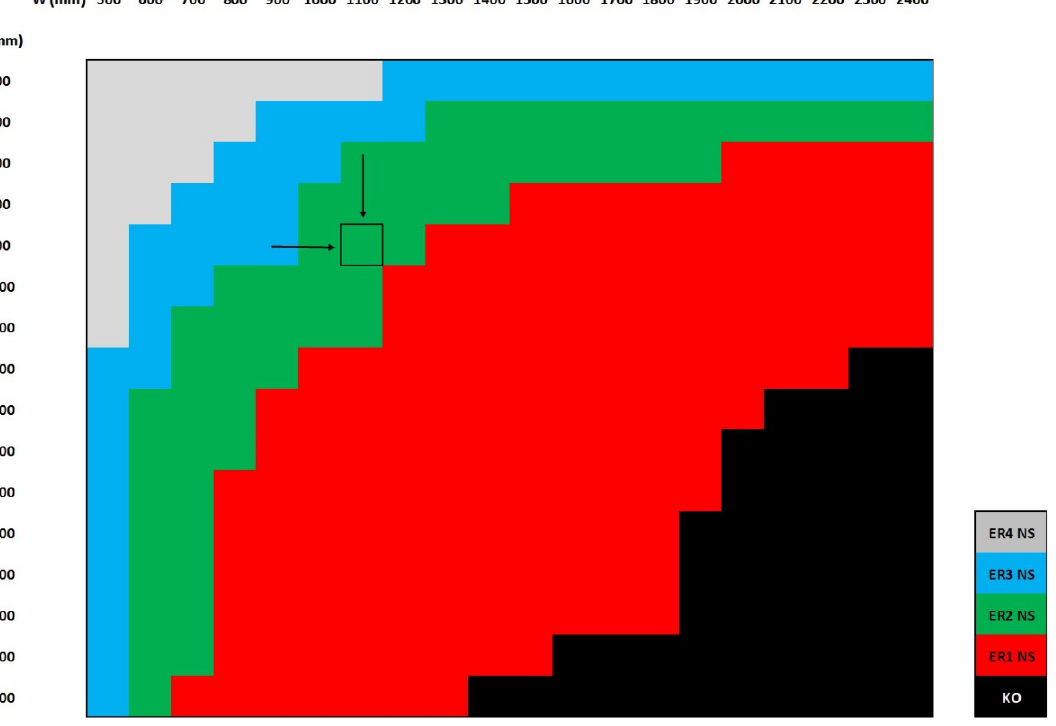
Fig. 2 : Glazing size effect on blast response for a